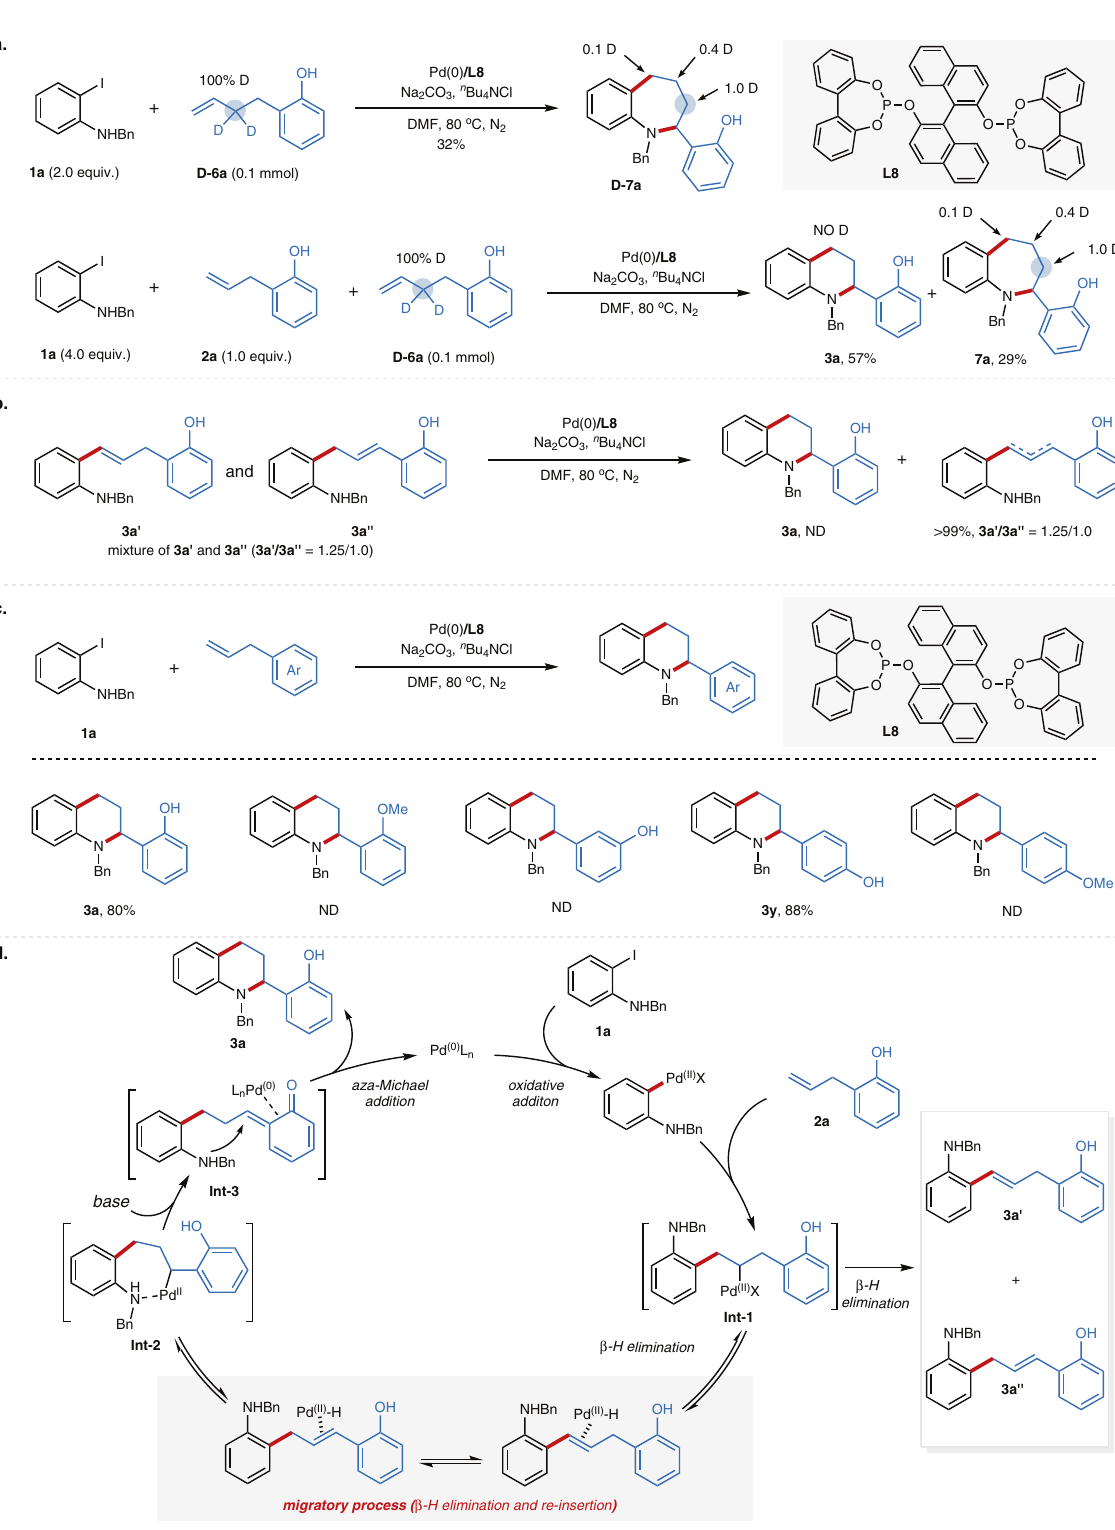
Fig. 3 | Mechanistic studies and proposed mechanism. a Deuterium experiments. b Transformation of isolated Heck-product. c Control experiments d Proposed mechanism. Ar, aryl; Bn, benzyl; L n , ligand; Me, methyl; DMF, N , N -dimethylformamide; ND, not